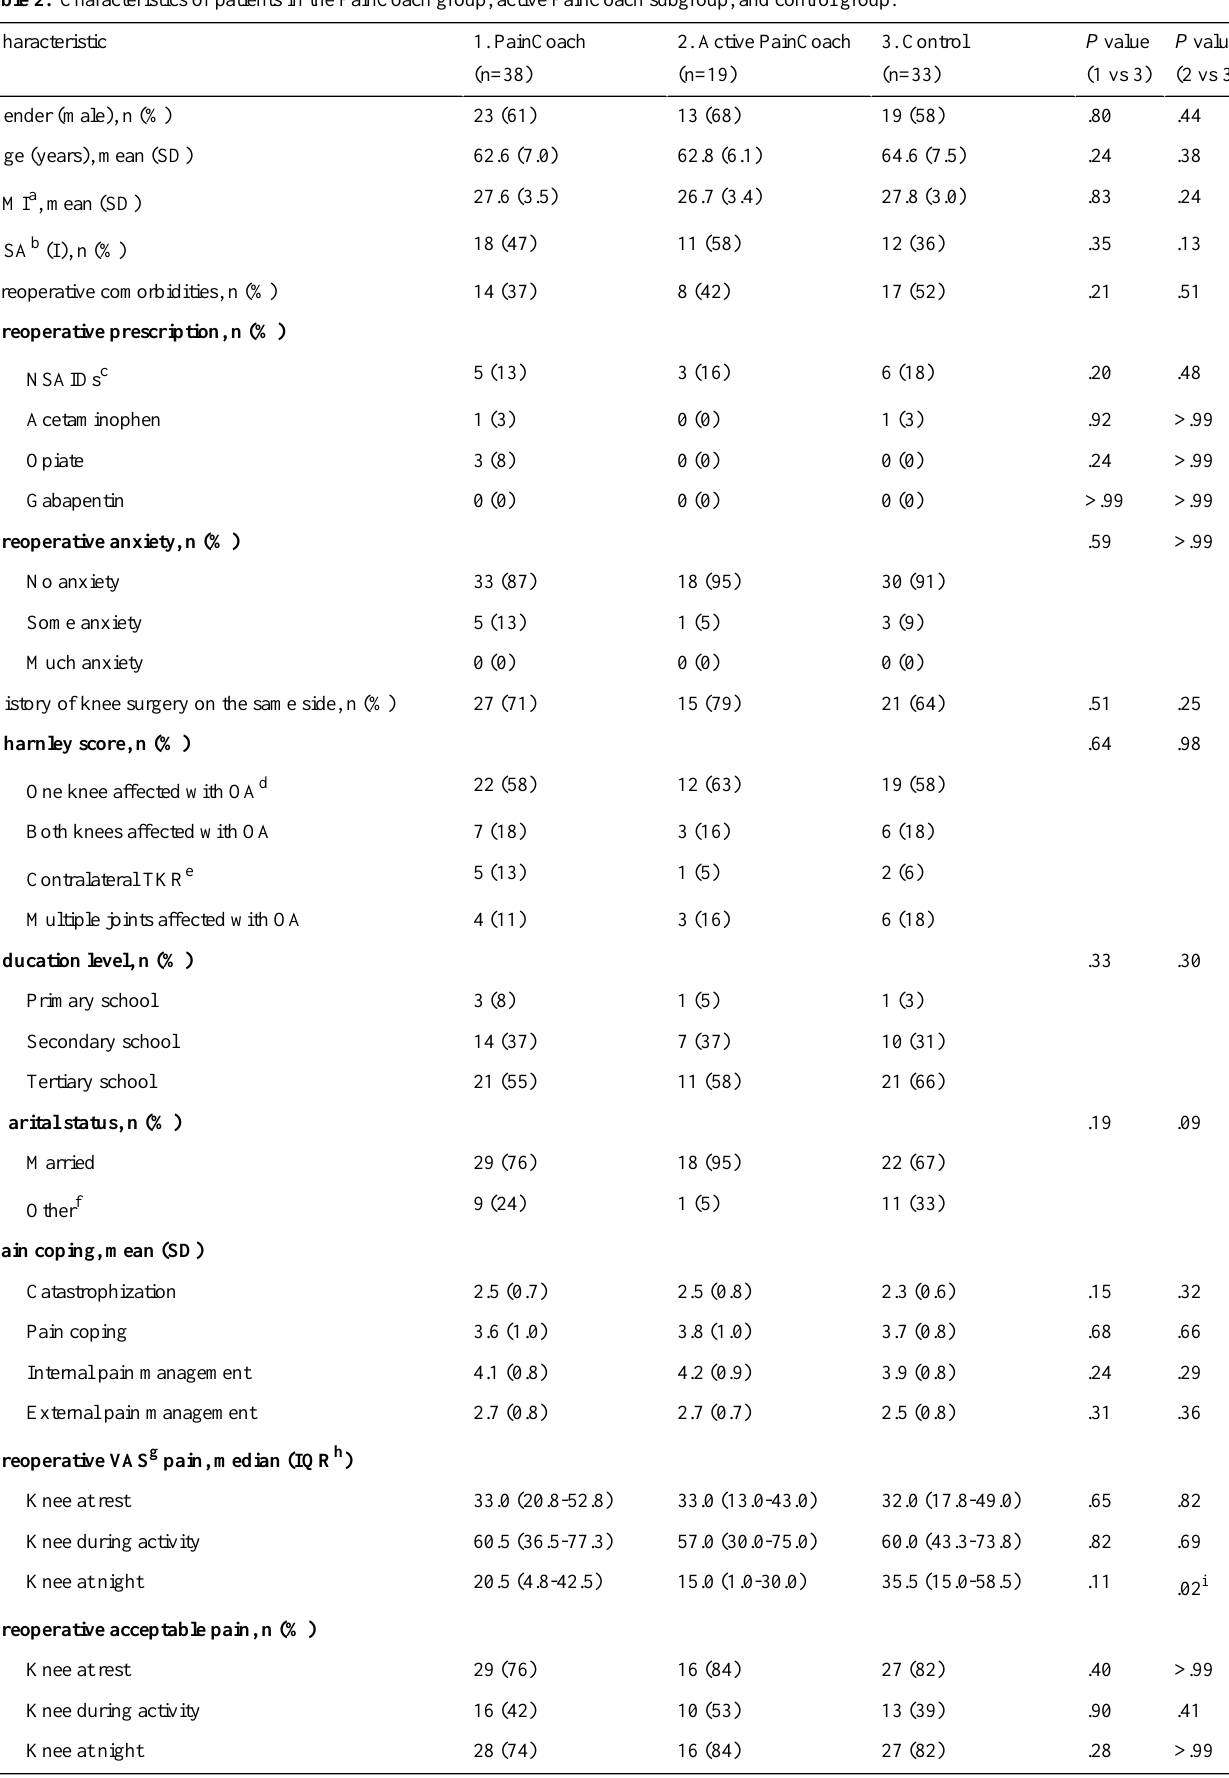
Table 2. Characteristics of patients in the PainCoach group, active PainCoach subgroup, and control